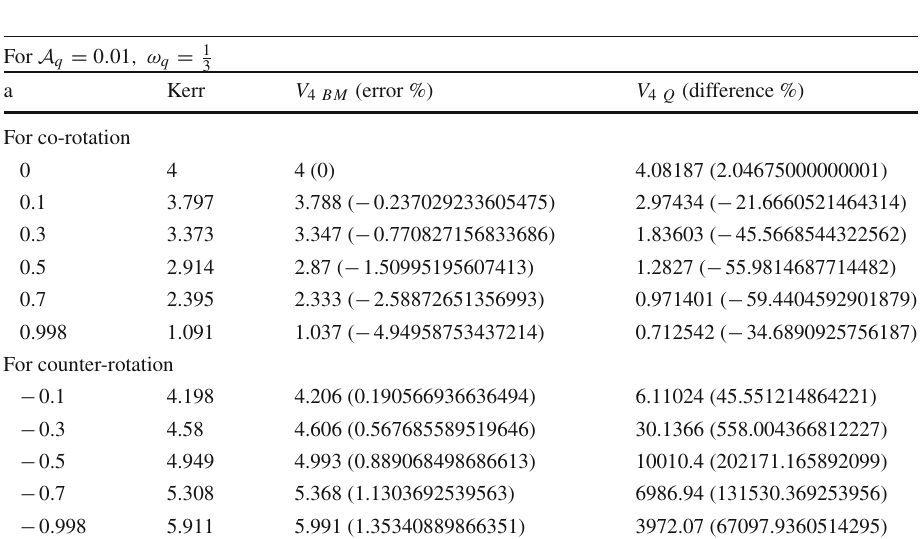
For A q = 0 . 01 , ω q = 1